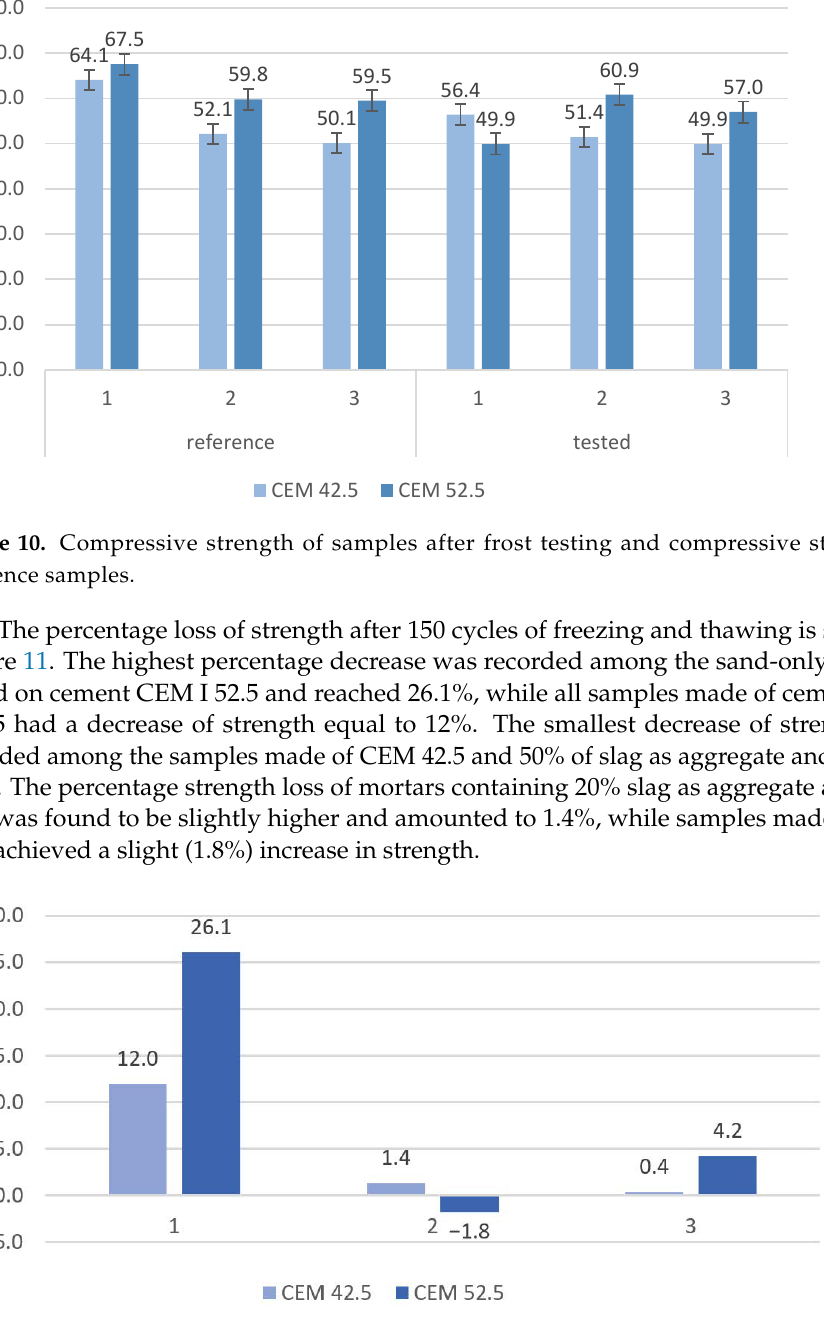
Figure 11. Percentage loss of strength after 150 cycles of frost resistance testing.